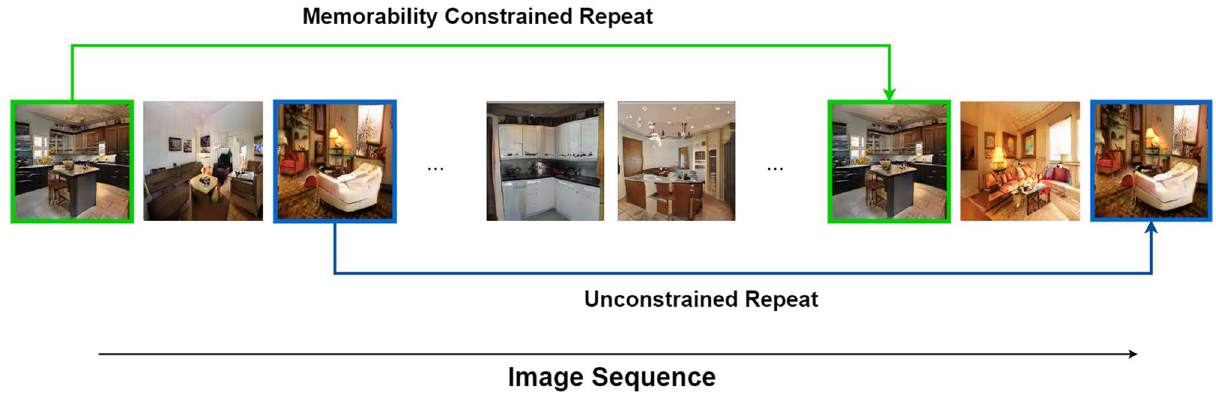
Figure 11. Memorability experiment